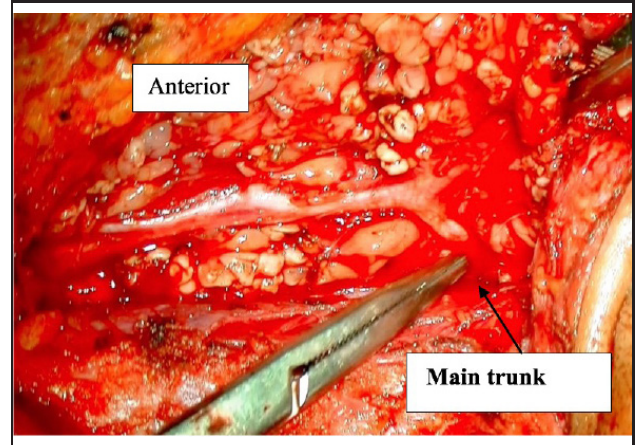
Figure 1. Intraoperative microscopic view of the Right main trunk and the branches of the facial nerve.